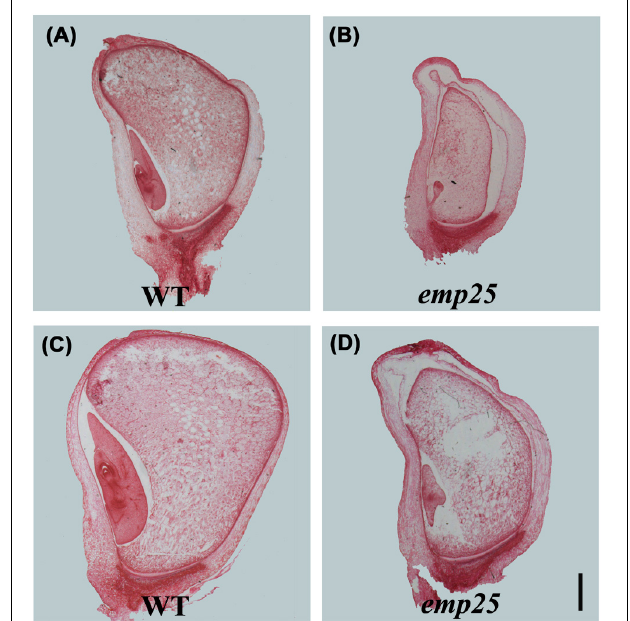
FIGURE 2 | Embryo and endosperm development of emp25. Paraffin sections of the emp25 mutant kernels and the corresponding WT siblings at 10 DAP (A,B) and 14 DAP (C,D) . Scale bar = 1